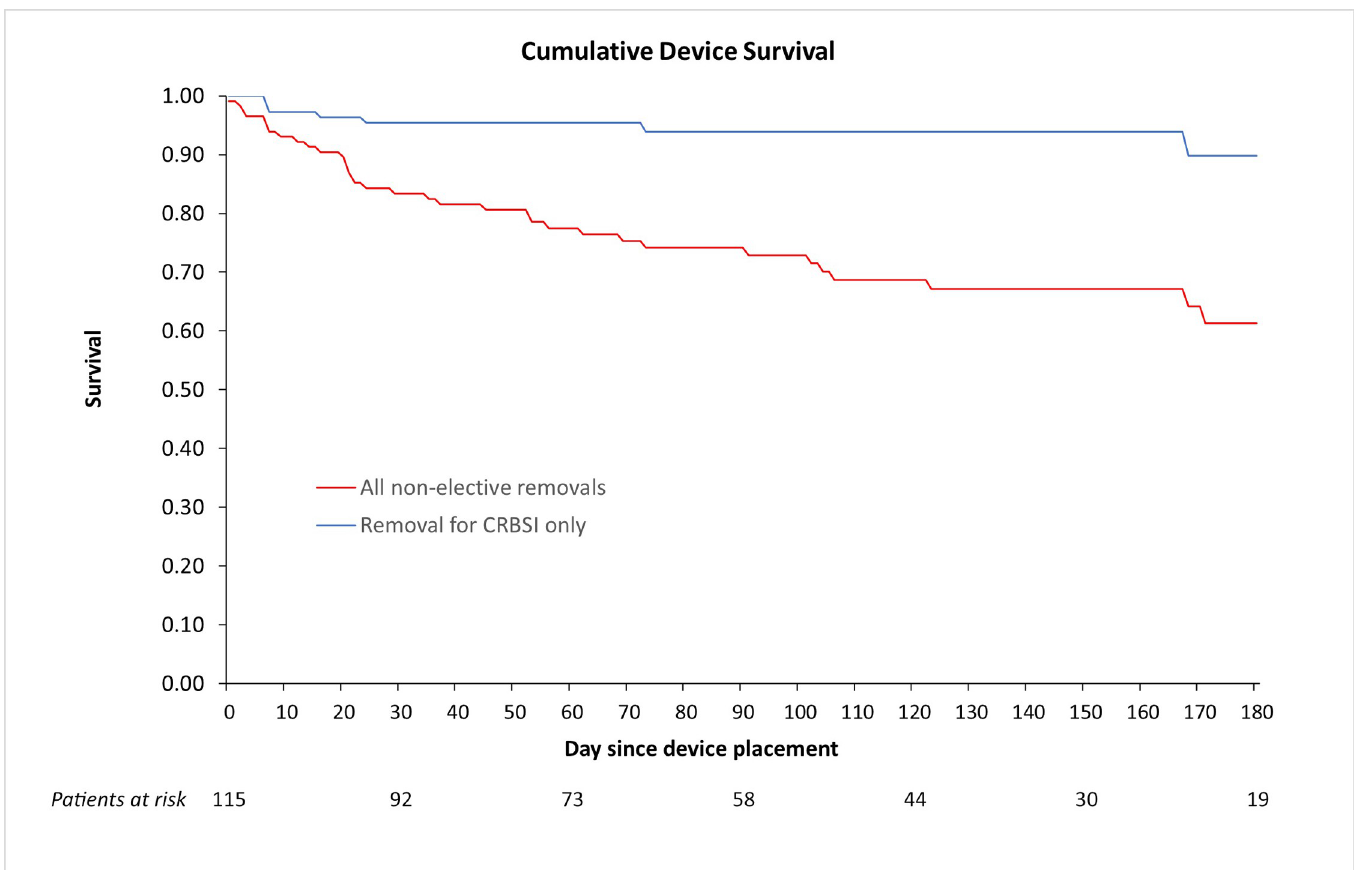
Fig 5. Kaplan-Meier survival curves for all non-elective device removals and removals for CRBSIs only.